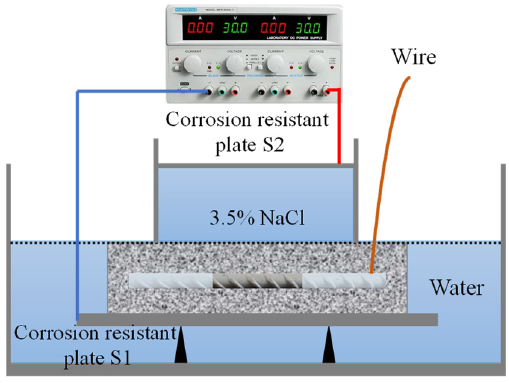
Figure 1. Test process diagram.